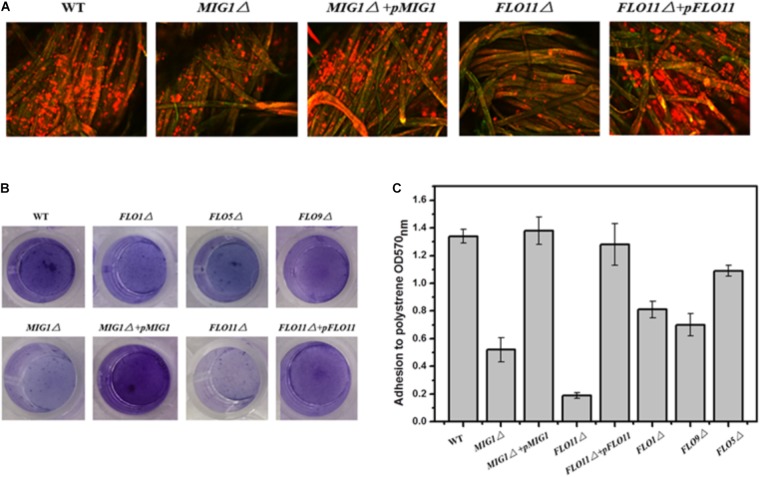
Biofilm formation. (A) CLSM images of wide-type, MIG1Δ, MIG1Δ + pMIG1, FLO11Δ and FLO11Δ + pFLO11 biofilms formed on fibers after 24 h fermentation. Strains were dyed orange-red by FUN-1 and polysaccharides were dyed green by Alexa Fluor 488-conjugated ConA. (B) Adherence abilities of wide-type, FLO1Δ, FLO5Δ, FLO9Δ, MIG1Δ, MIG1Δ + pMIG1, FLO11Δ, and FLO11Δ + pFLO11 strains were assayed after incubation in polystyrene 24 h. Wells were washed twice with PBS (in 200 μL) to move away free cells and stained with 1% crystal violet. Wells were washed repeatedly with water and photographed. (C) Adhesion was expressed as OD570 and was measured by solubilizing crystal violet in acetic acid.